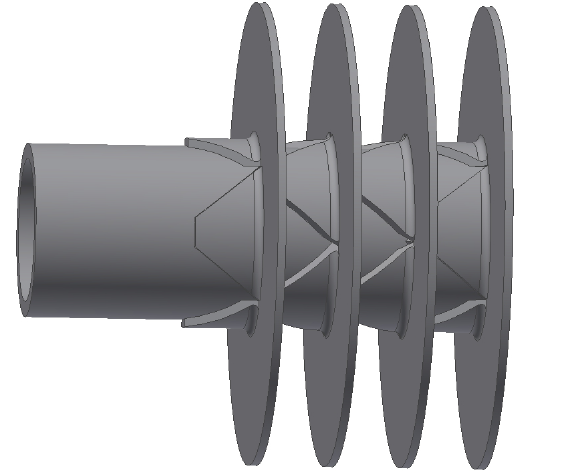
Figure 7. The protrusions on the